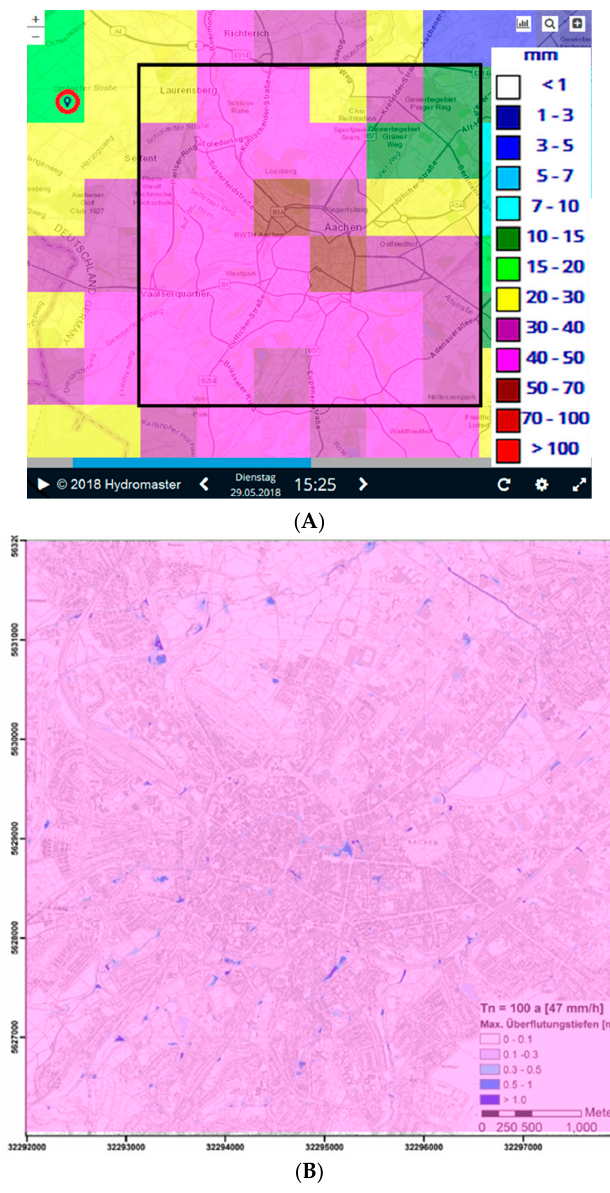
Figure 5. ( A ) Measured rainfall pattern (14:25–15:25) of the 29 th May flood event in the city of Aachen including the case study area (black rectangle) [53]; ( B ) Rainfall pattern (47 mm/h) used as input for the pre-simulated scenario 3 (spatio-temporal uniformly distributed)